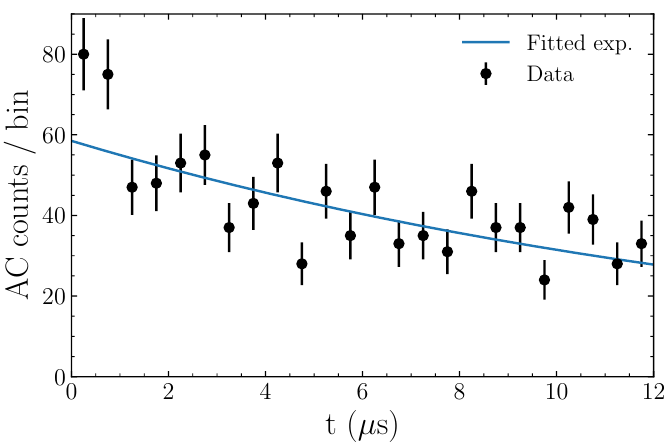
Figure 3 . Total AC counts per bin, compared to the results of the exponential (cid:12)t employed in ref. [36] and described in section 3.2 used to model the steady-state background. No cuts on the observed number of PE have been applied to this